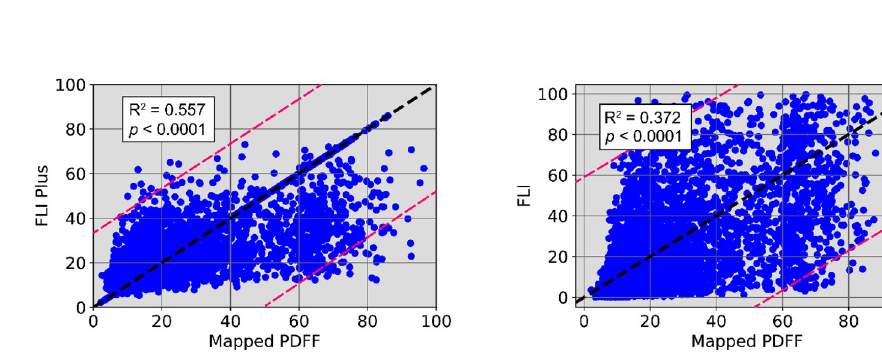
Fig 4. Correlation of fatty liver index (FLI) Plus (a) FLI (b) with proton density fat fraction (PDFF) mapped to the FLI risk range and threshold. (a) FLI+ versus mapped PDFF. (b) FLI versus mapped PDFF.